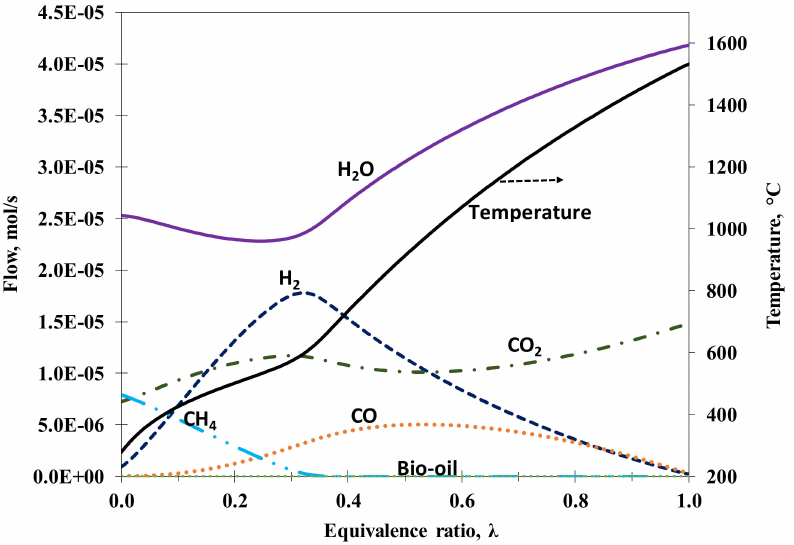
Figure 13. Thermodynamic equilibrium plots showing syngas composition and temperature obtained at S/C = 2.2 and 1 bar while varying λ from 0 to 1 for bio-oil surrogate (m.f.) ATR.